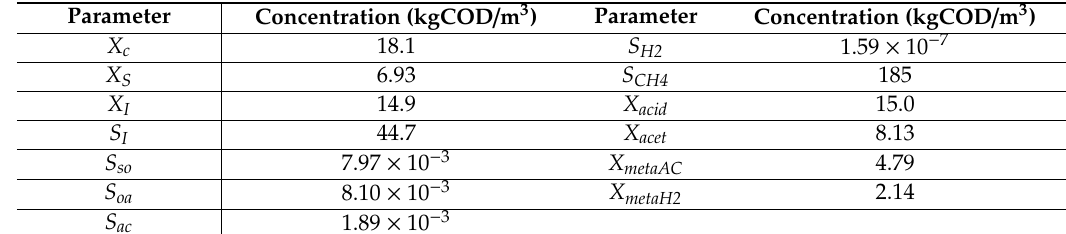
Table 8. Components concentrations under steady-state conditions, after 60